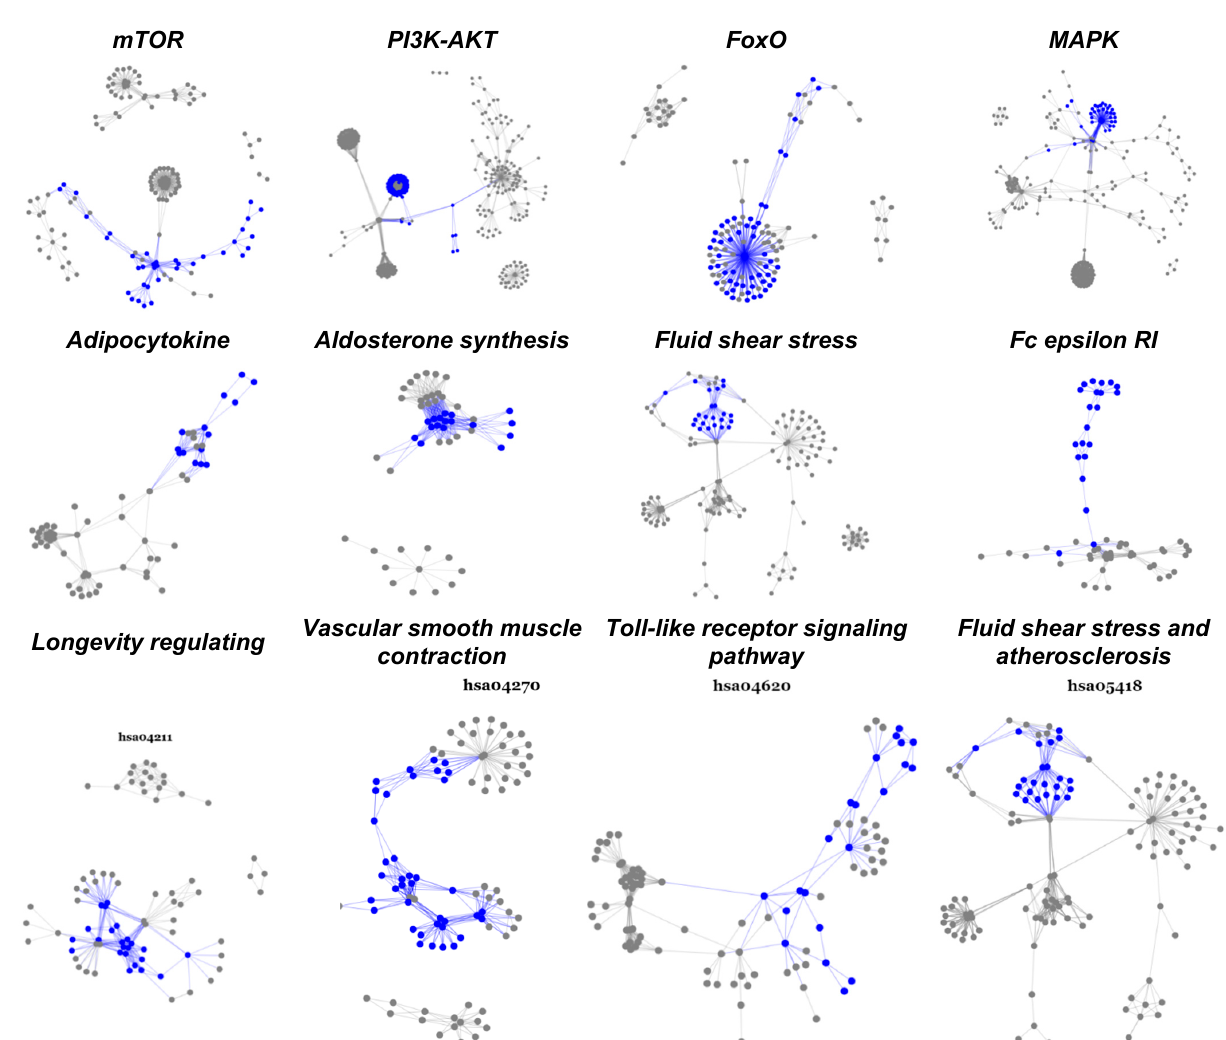
Figure 3. Statistically significant and biologically active subpathways in TNBC chemoresistance. This figure displays twelve significantly activated pathways overlapped between paired and unpaired cohorts. The highlighted parts (blue) are subpathways upregulated as the breast tumor developed from pre- to post-chemotherapy.